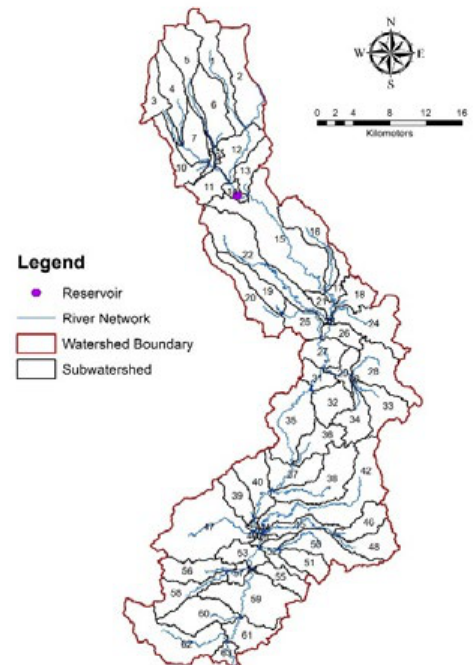
Fig. 2: Delineated Subwatersheds of Muleta